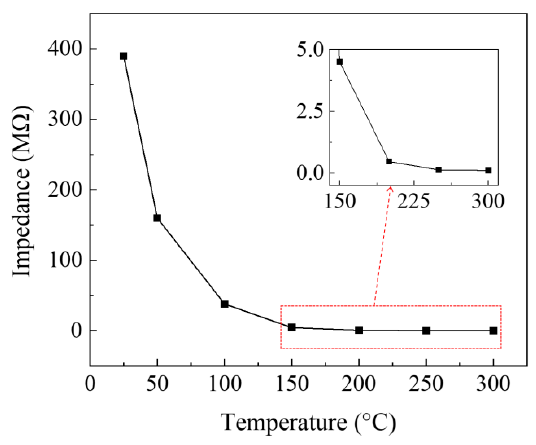
Figure 3. Impedance vs. temperature from Nyquist plot.